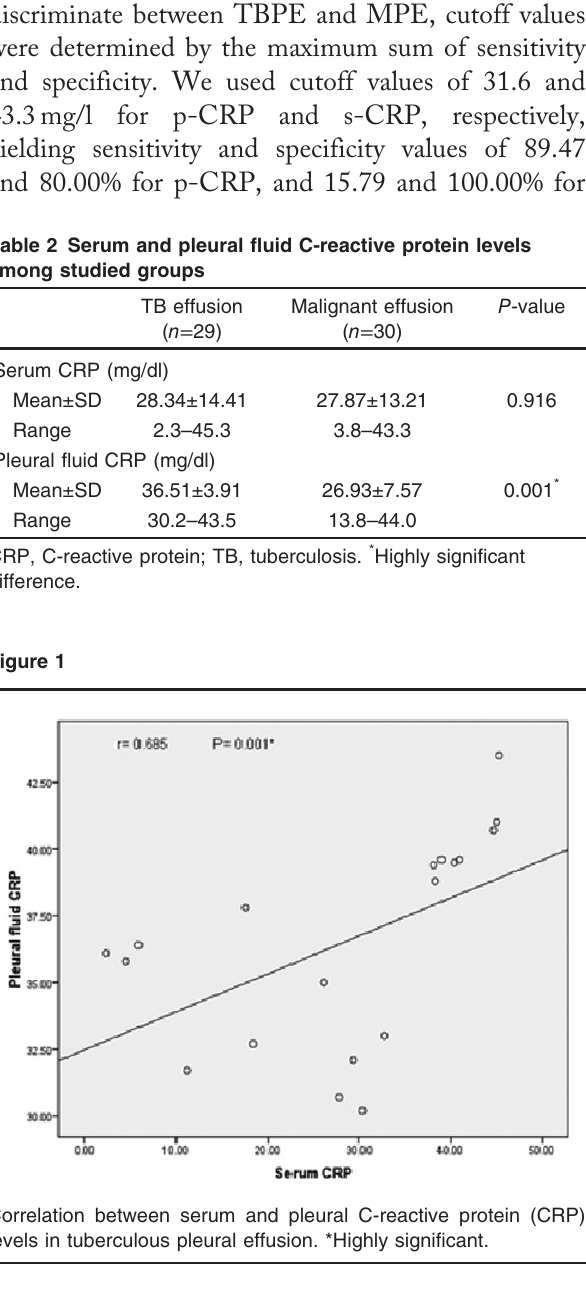
Correlation between serum and pleural C-reactive protein (CRP) levels in tuberculous pleural effusion. *Highly significant.